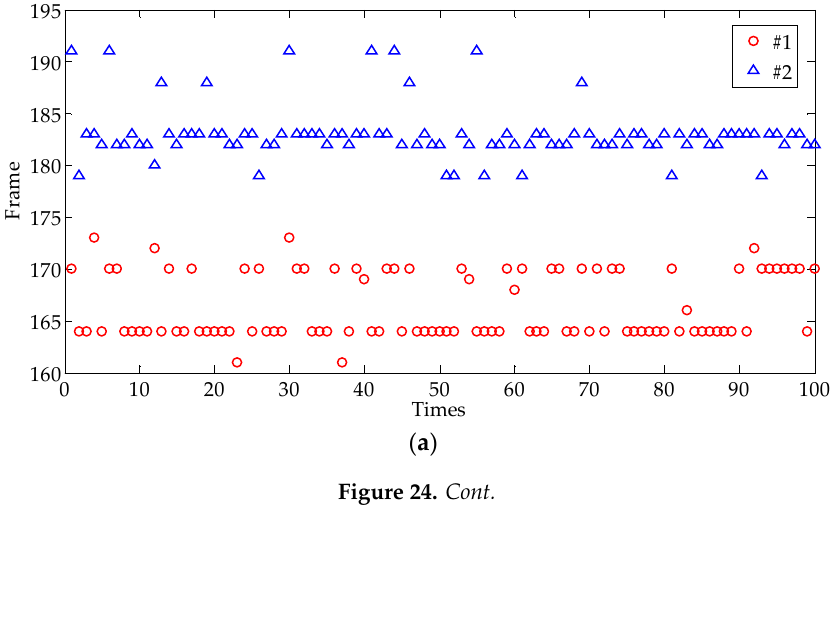
Figure 23. The 3D scatter diagram of selection frames with the sensitive region size variation: ( a ) The 3D scatter diagram of selection frames for #1; ( b ) The 3D scatter diagram of selection frames for #2.